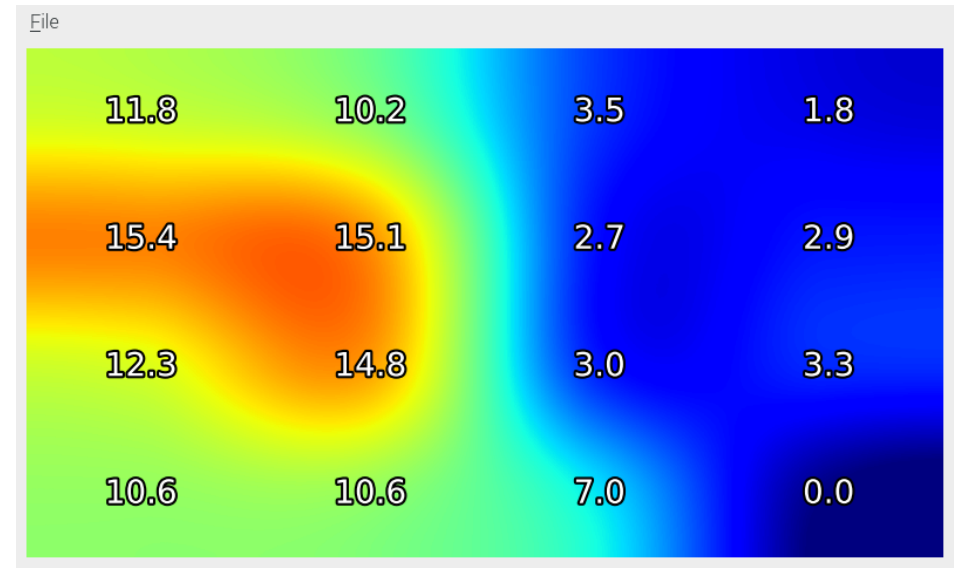
Figure 12. A screenshot of pressure map showing pressure values (in kPa) on proposed embedded system’s screen when seated person leaned to left.